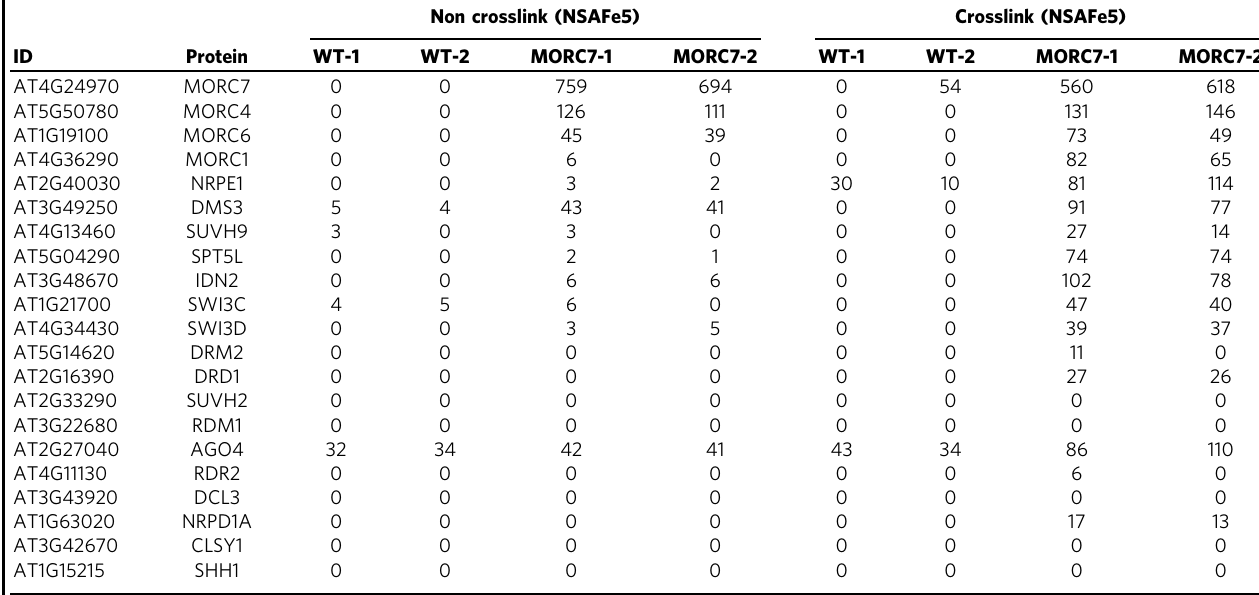
Table 1 IP-MS of